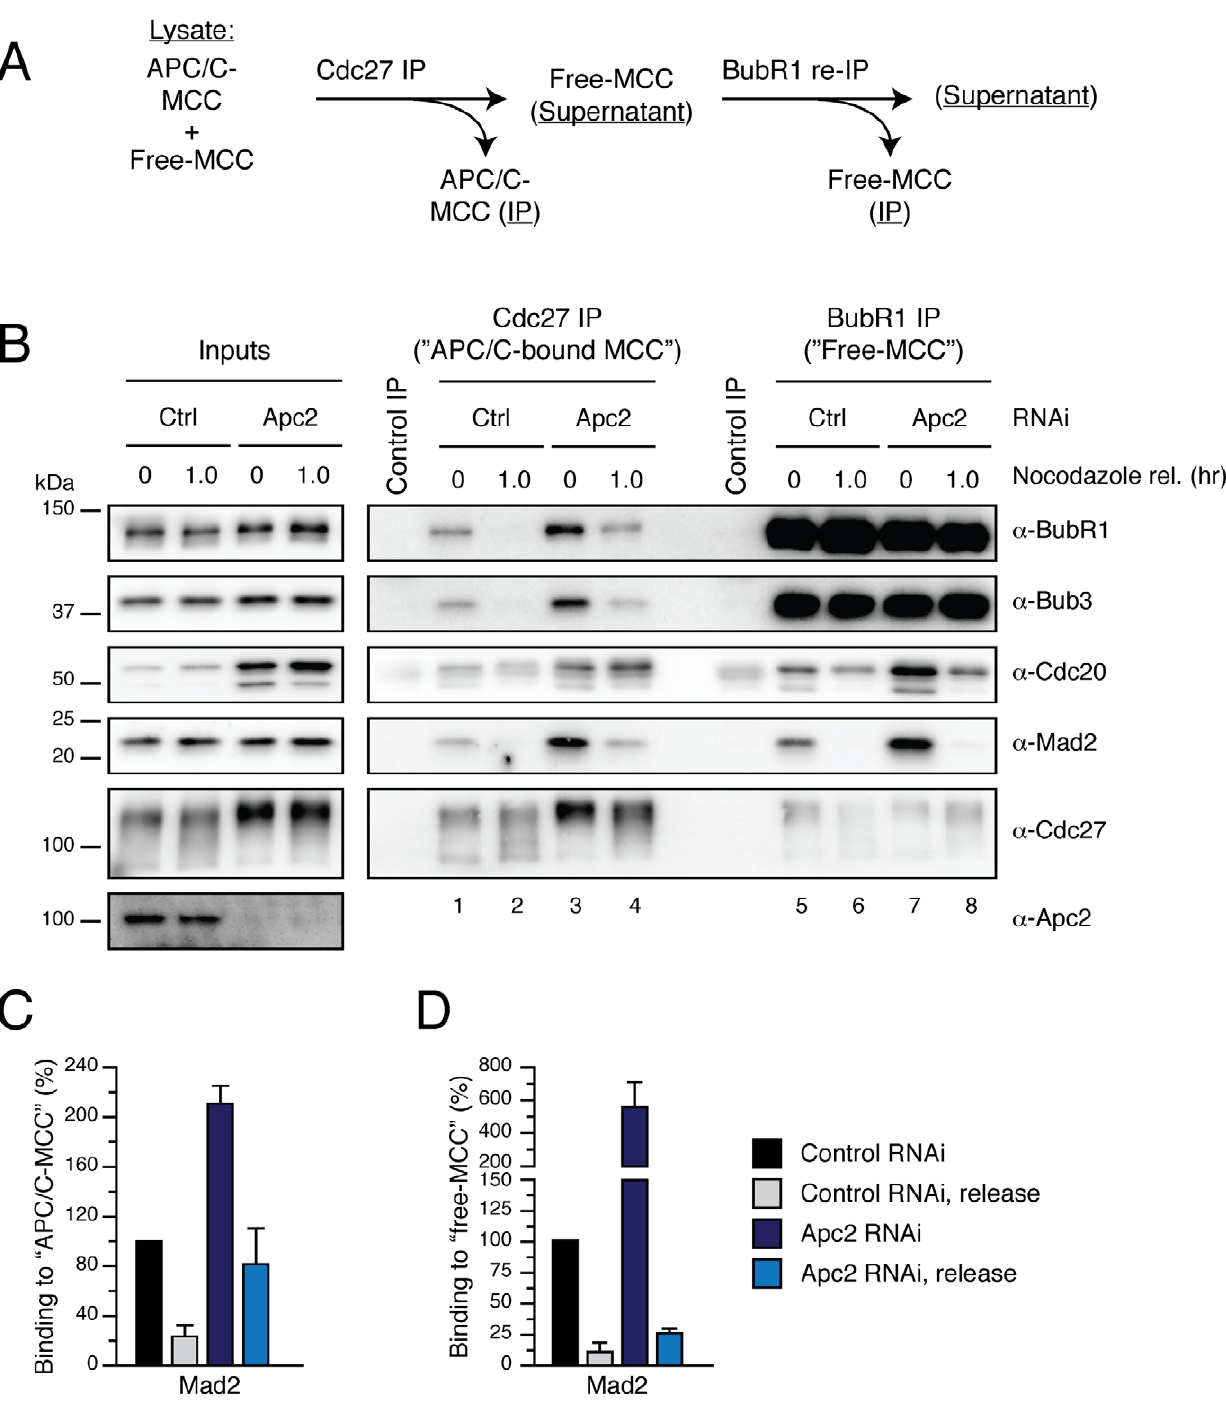
Figure 8. APC/C activity is required for releasing itself from the MCC. ( A ) Schematic representation of the strategy for the selective isolation of APC/C-MCC and free MCC. ( B ) Immunoblot of immunocomplexes isolated from mitotic HeLa cells released into media containing MG132, ZM447439 and AZ3146 after Apc2 RNAi. ( C, D ) Bar graph quantifying the amount of Mad2 bound to APC/C-MCC (C) or free-MCC (D) under the different conditions described in (A). Values represent the mean 6 s.e.m. of three different experiments.